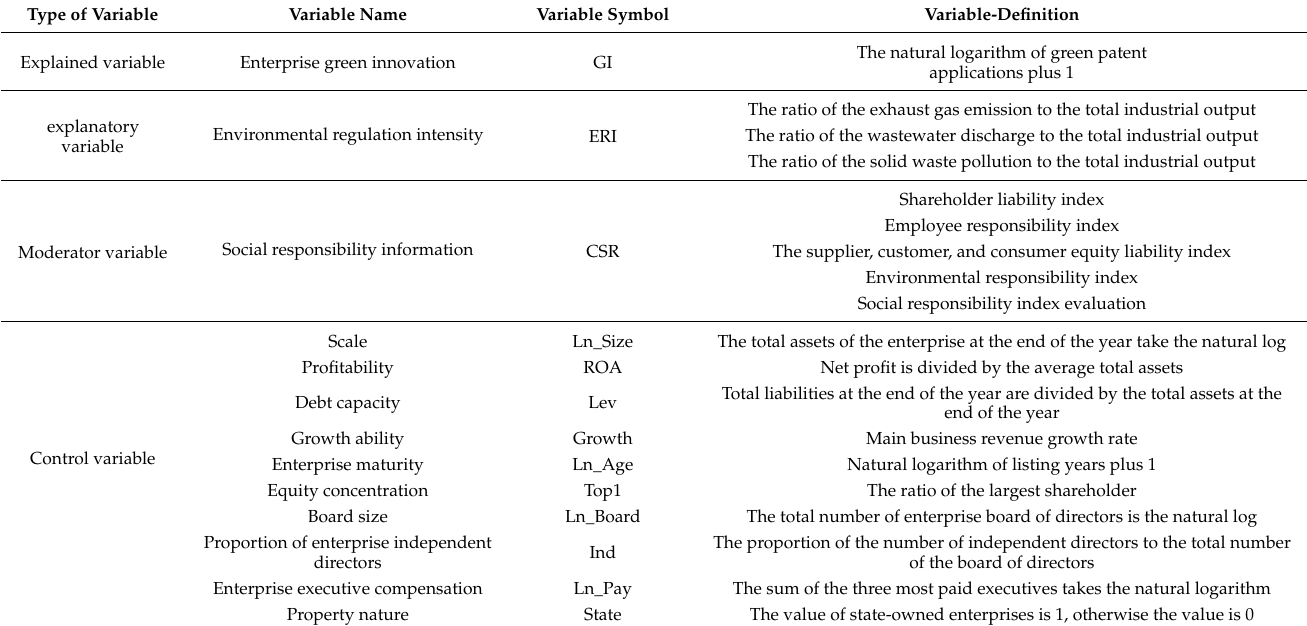
Table 1. Variable Definition and